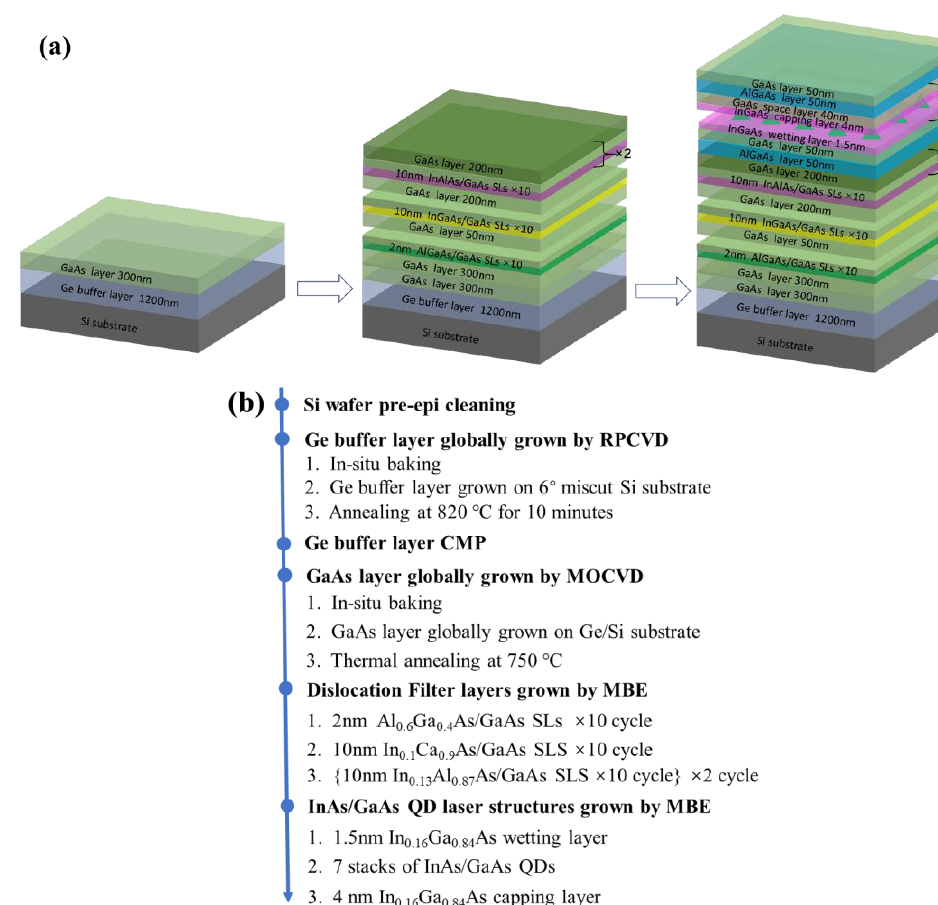
Figure 1. ( a ) Schematic diagram of InAs/GaAs QD grown on Ge-buffered Si substrate with multi-SLSs dislocation filter layers; ( b ) Flow process of InAs/GaAs QD.